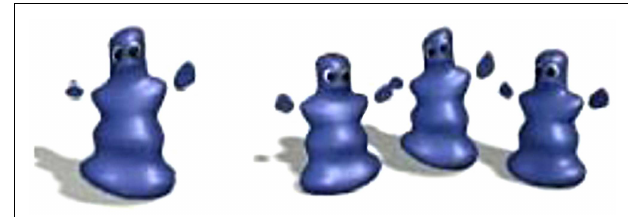
FIGURE 1 | Male infants with higher postnatalT show stronger visual preferences for the group of figures